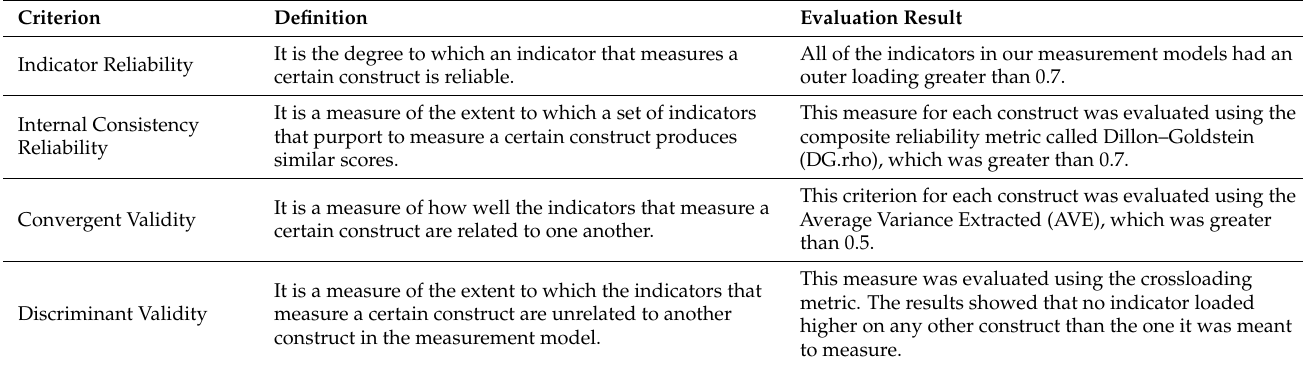
Table 5. Evaluation of measurement models [14,39–41].